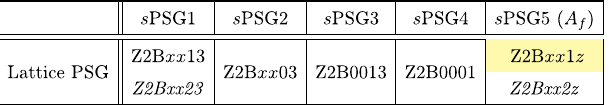
Ref. [17] and reviewed in Appendix B 4. All of the spin liquids listed are found to be proximate to the π -flux phase SU 2 n 0 though not necessarily U 1 C n 0 n 1 . While the symmetry fraction- alization of s PSG 1 and s PSG 5 corresponds to multiple fermionic PSGs, the two that are italicized (Z 2 B xx 23 and Z 2 B xx 2 z ) are not proximate to U 1 C n 0 n 1 and therefore cannot represent the Higgs phases we obtain (see Appendix B